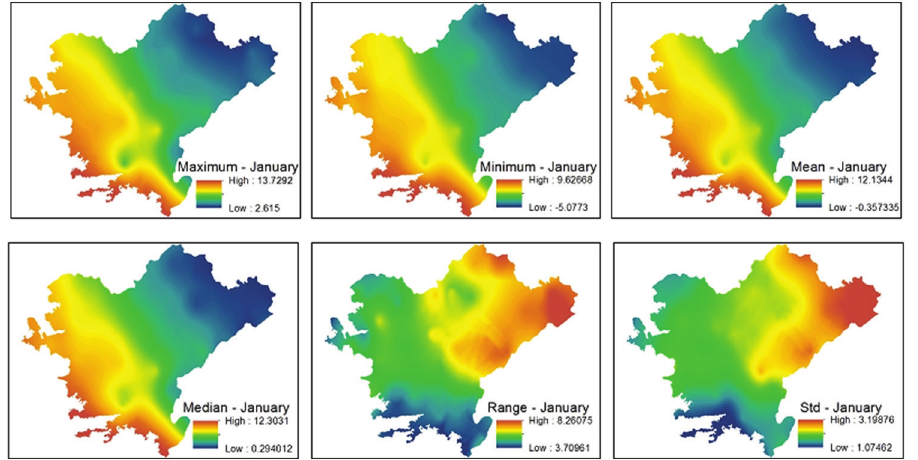
Figure 7 - Cell statistics of the temperature for the month of